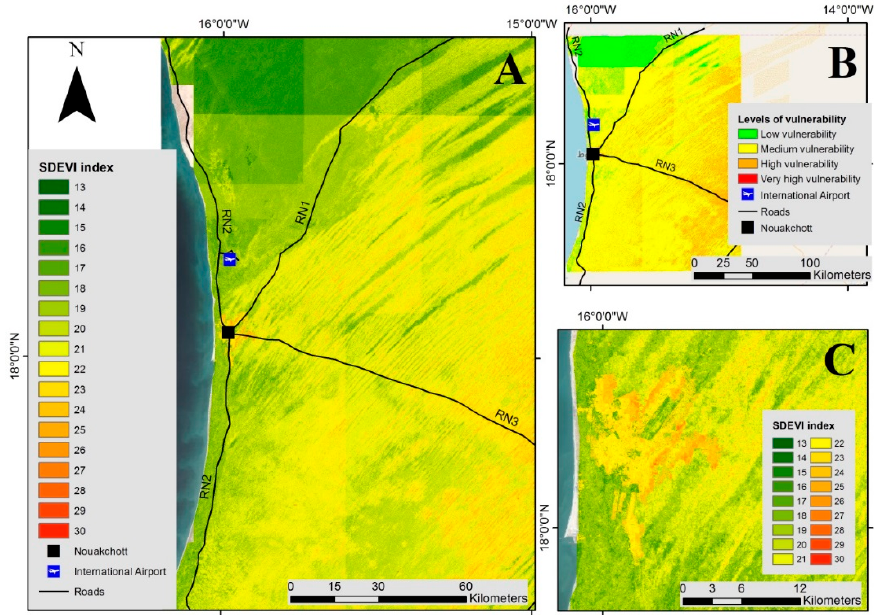
Figure 7. ( A ) Map of the SDEVI index to assess vulnerability to sand dune encroachment over the study area, ( B ) Levels of vulnerability according to Table 1 and ( C ) vulnerability map over Nouakchott city (bottom-right). Open street map is the basemap in the images.